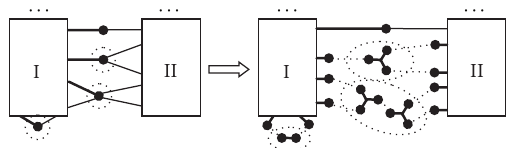
Figure 1: Decomposition of the complex interconnections.